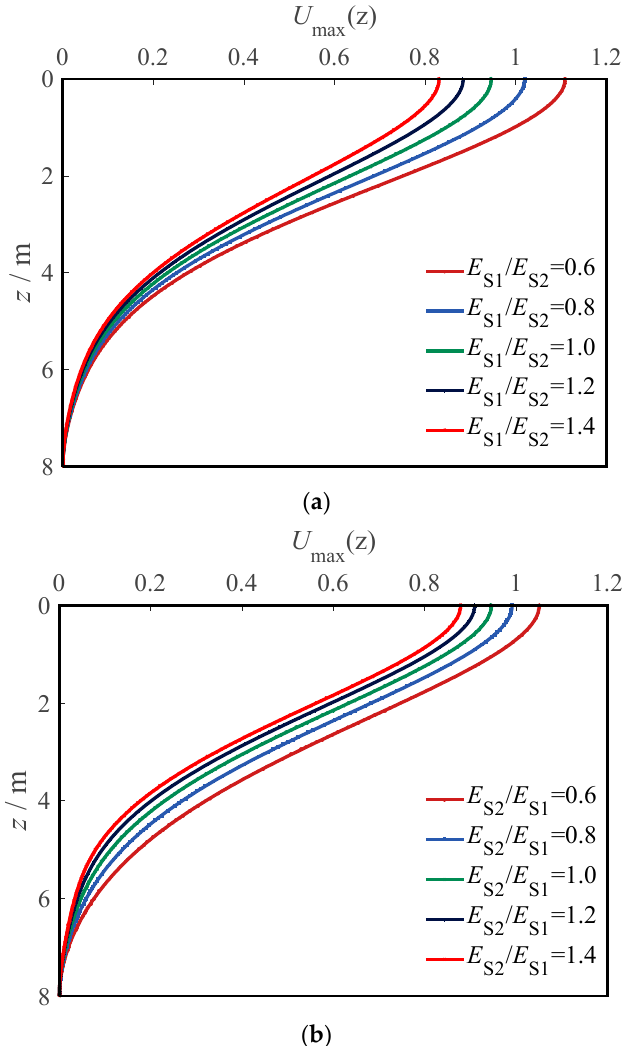
Figure 4. Influence of shear modulus of soil on the horizontal displacement of TP. ( a ) Variable shear modulus of upper soil and ( b ) variable shear modulus of lower soil.